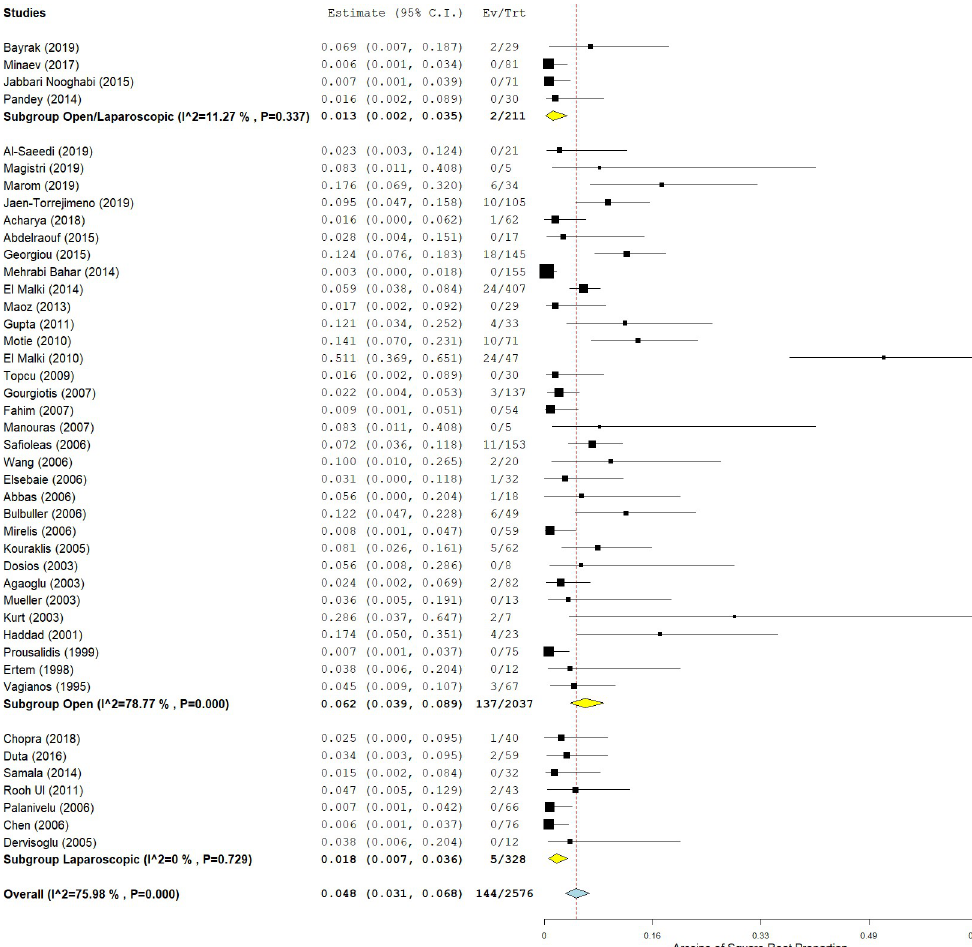
Fig 5. Forest plot of the recurrence rate after endocystectomy for cystic echinococcosis, with subgroup analysis of laparoscopic and open